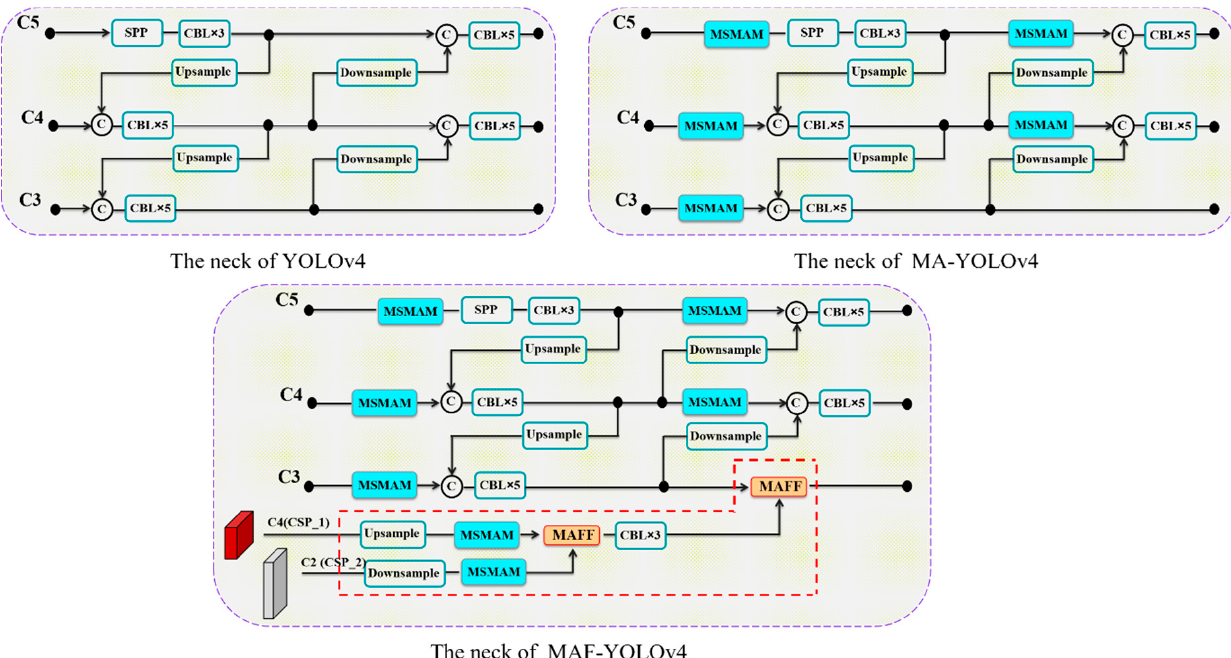
Figure 4. Structure diagram of YOLOv4 model; the red cube represents C4(CSP_1), which is the intermediate feature map output by the first small residual block in the C4 layer.